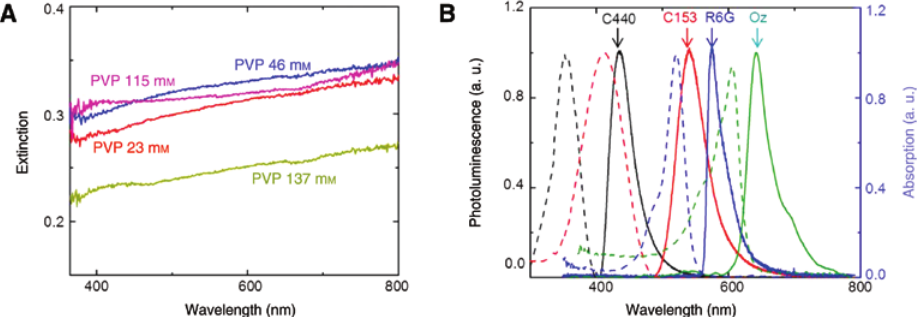
Figure 4: Optical characteristics of the materials. (A) Extinction spectra of Ag NF dispersion fabricated from different PVP concentrations. (B) Absorption spectra and fluorescent spectra of the